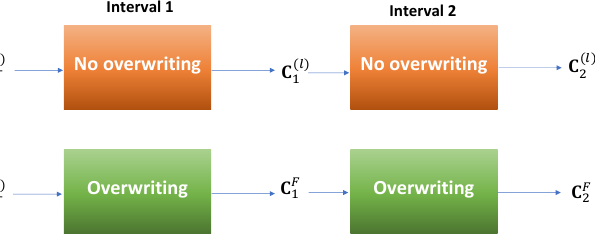
Figure 2. No overwriting ( top ) vs. overwriting ( bottom ) for the first two